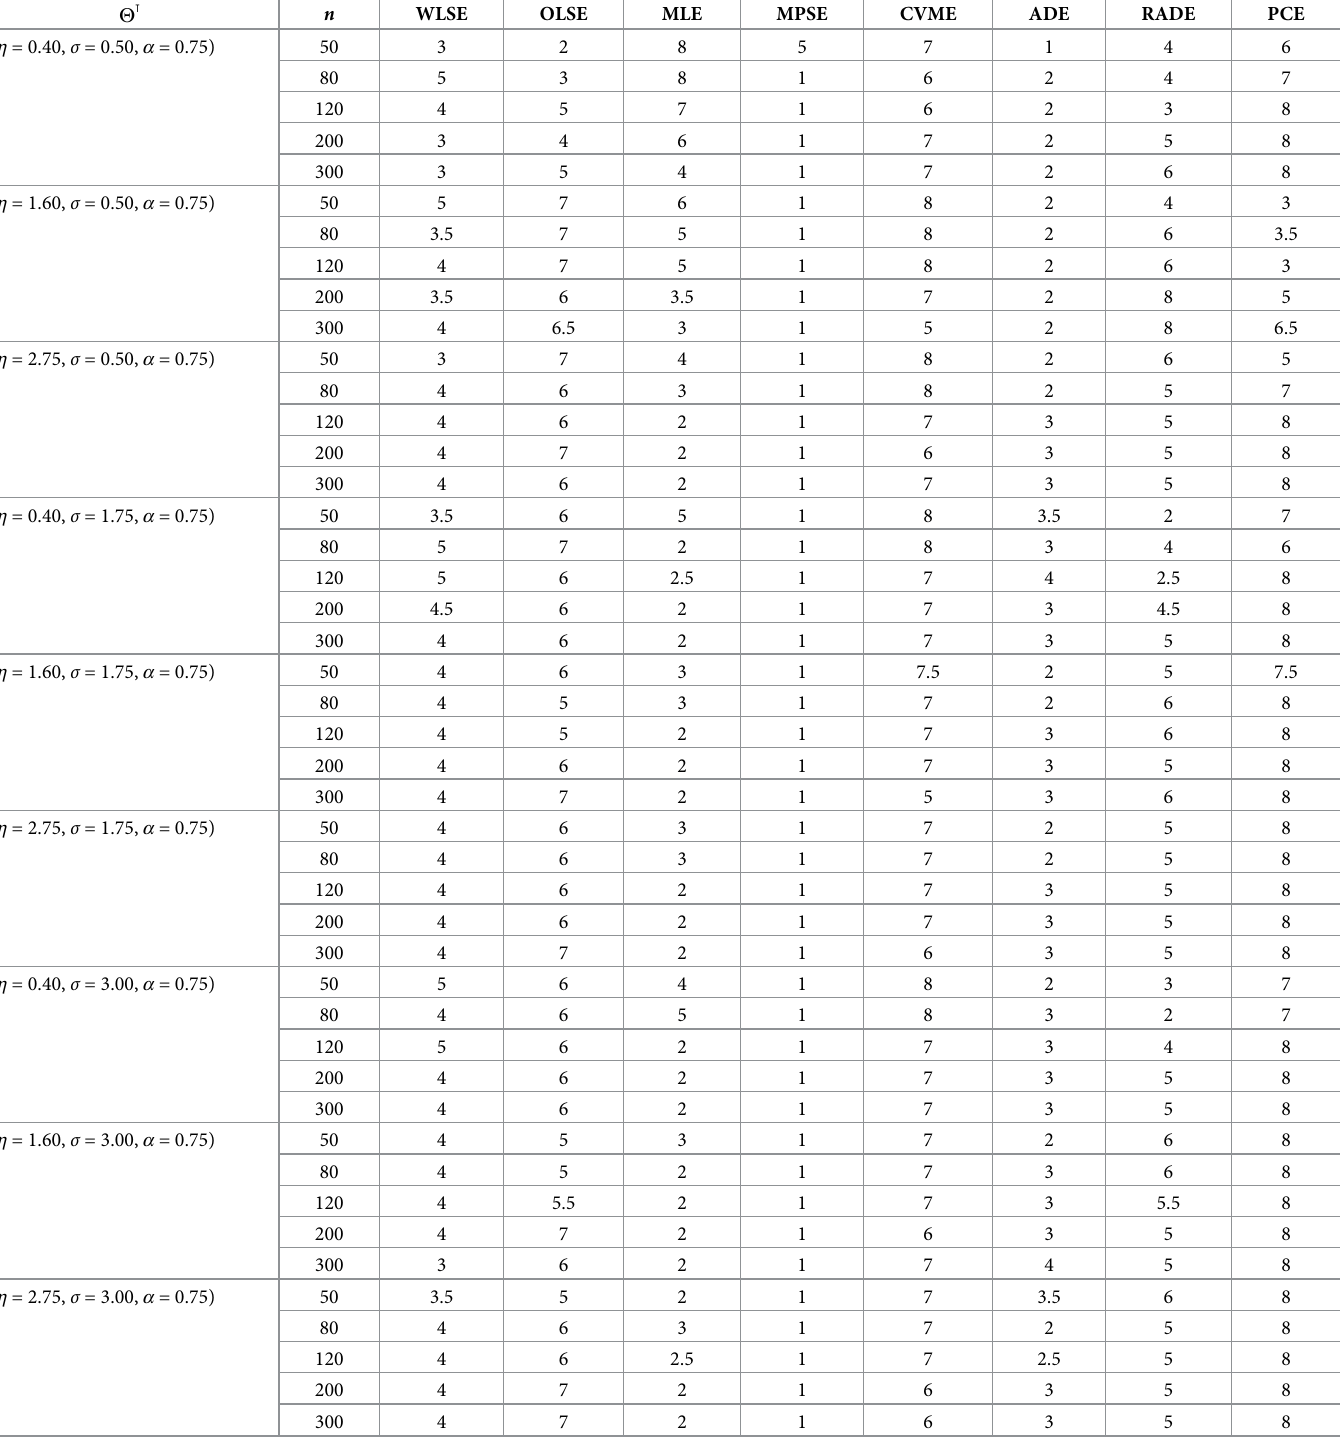
Table 8. Partial and overall ranks of all estimation methods for various combinations of Θ . Y ⊺ n WLSE OLSE MLE MPSE CVME ADE RADE PCE ( η = 0.40, σ = 0.50, α = 0.75)